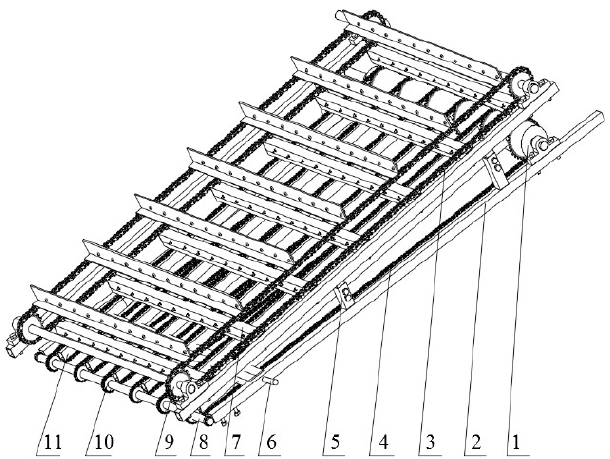
Figure 1. The clamp conveying type residual film collector. 1. roller; 2. rack; 3. clamp plate conveying chain; 4. residual film conveying chain; 5. adjusting stand; 6. hanging lever handle; 7. clamp plate; 8. transmission shaft; 9. chain wheel;10. grooved chain wheel; 11. bracket.